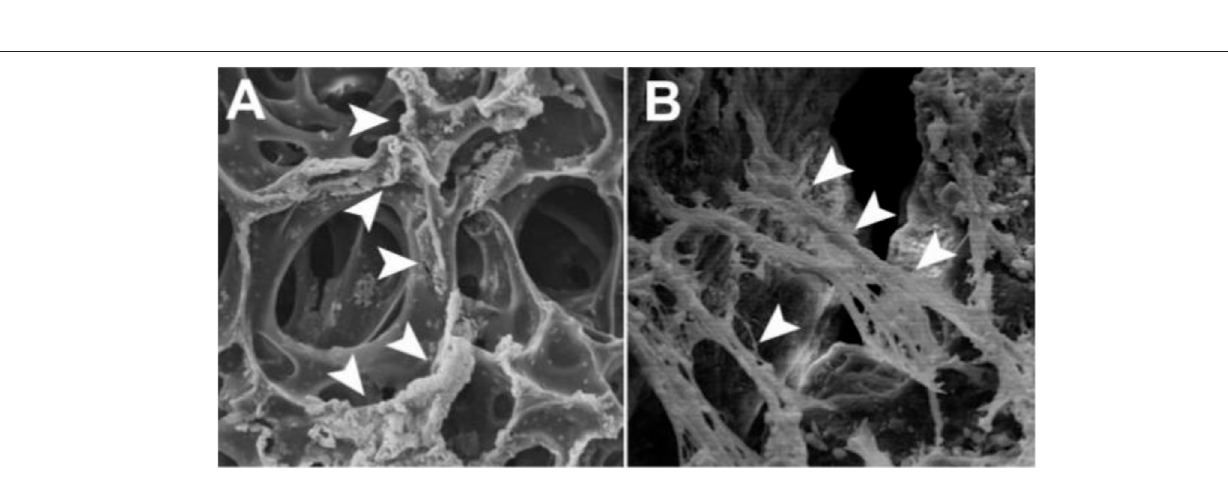
Frontiers in Bioengineering and Biotechnology |